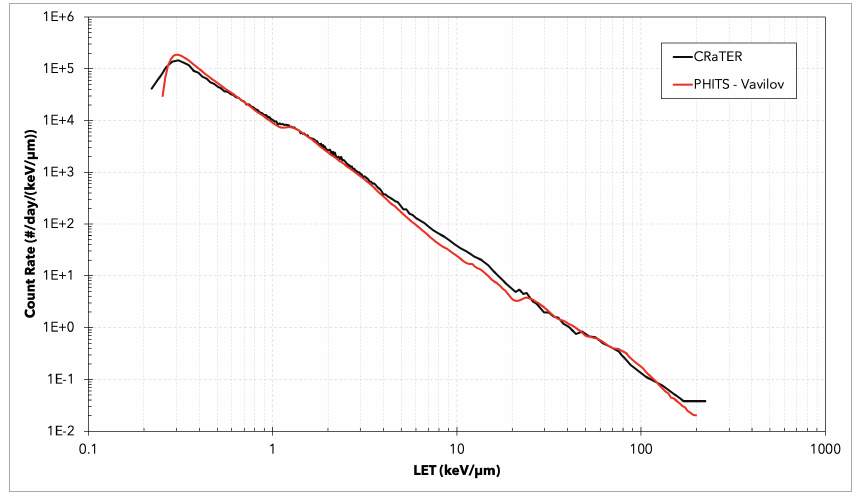
Figure 3. A comparison between the LET spectra in D6 obtained from CRaTER measurements and PHITS simulations (with Vavilov energy straggling) during a period of solar